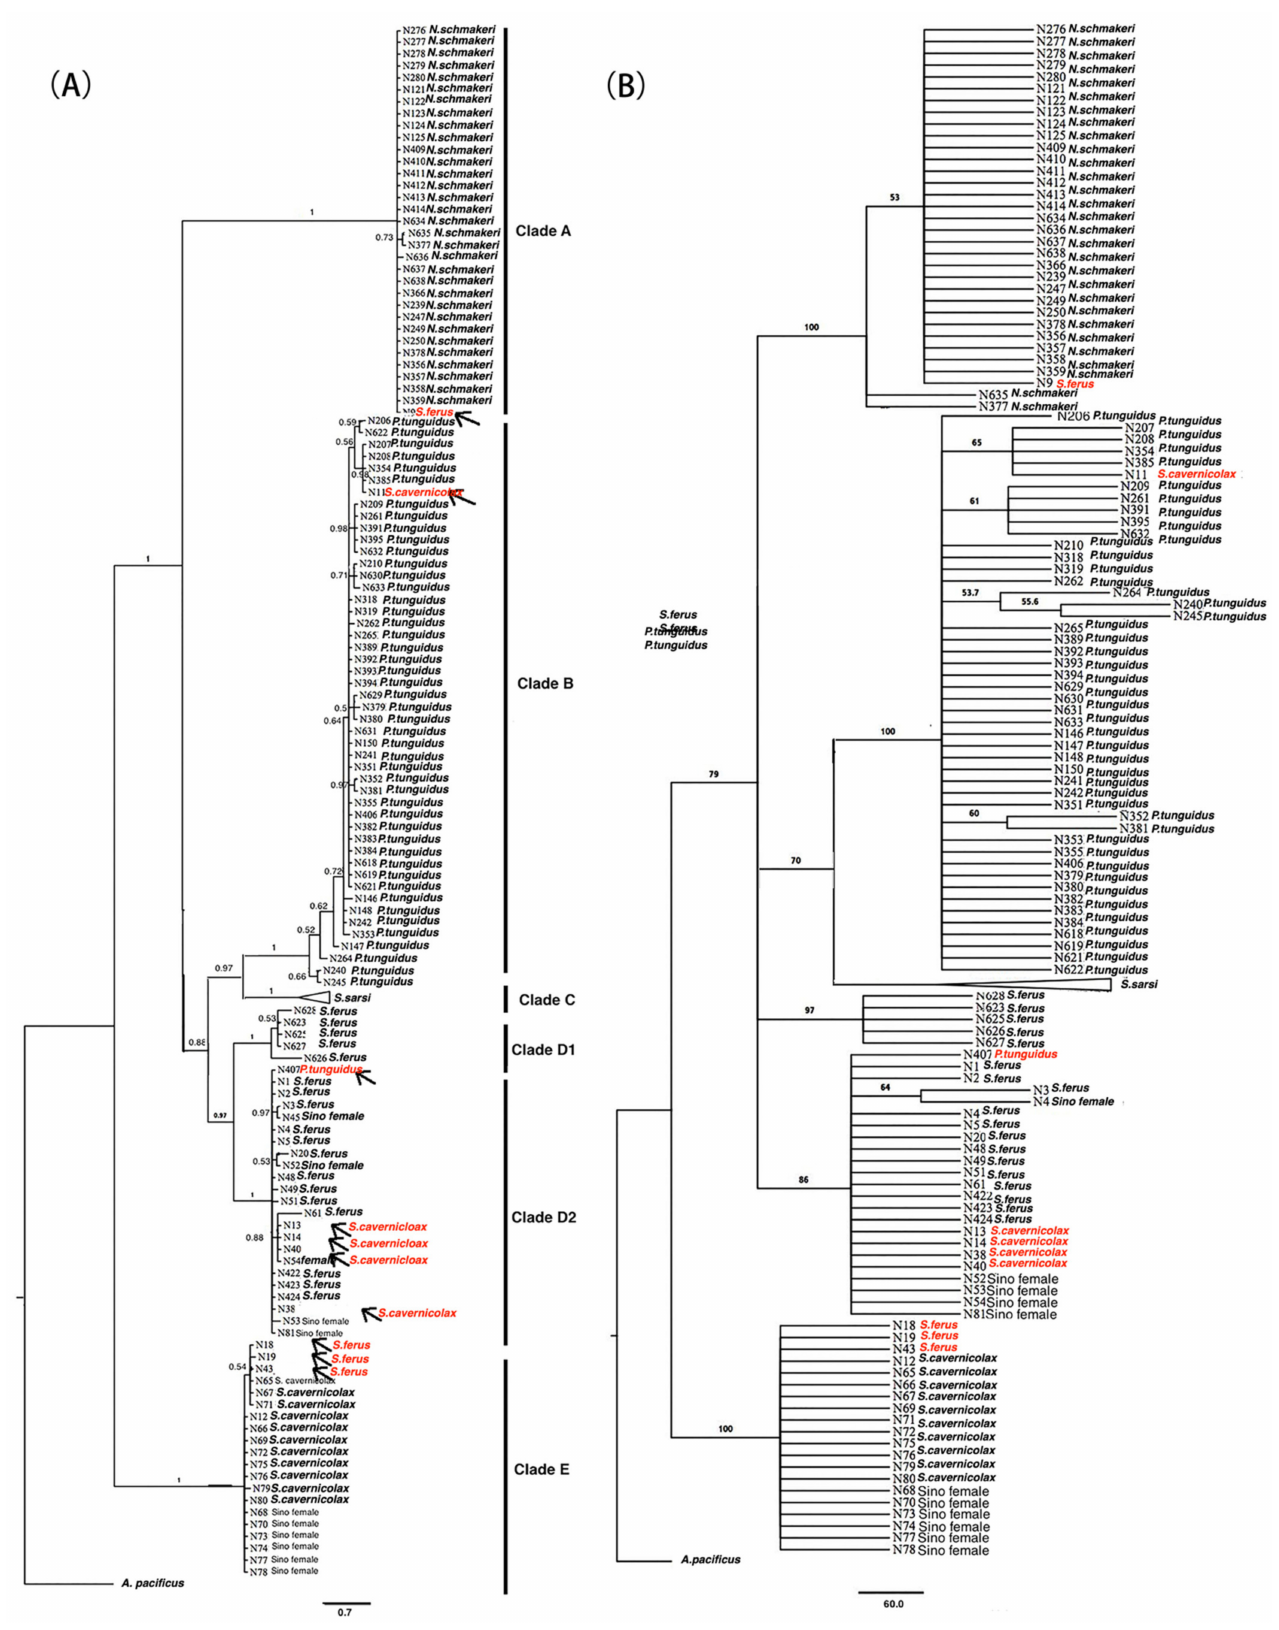
Figure 3. Phylogenetic tree of investigated species based on the sequences of their ITS genes by Bayesian inference ( A ) and maximum likelihood method ( B